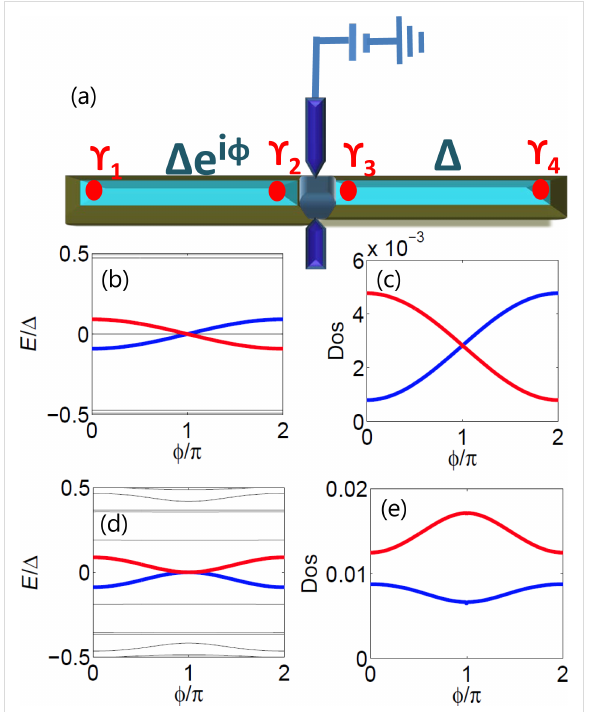
Figure 1: (a) Schematic setup of an experiment in which two STM leads or normal leads are connected to a Top-JJ that supports the MFs. (b) Energy spectrum of the Top-JJ with chemical potential μ = − 2 t , which lies in the topological region. The two MFs, which are localized at the junction, interfere with each other and display a 4 π oscillation. (c) DOS for electron part of the coupled MFs in the Top-JJ. Both even parity state and odd parity state show a parity-correlated 4 π oscillation. (d) Energy spectrum of the Top-JJ with chemical potential μ = − 2 t + 5.7 Δ , which lies in the trivial region, and the disorder strength w = 0.13 t . In this case, there does not exist any MF that is localized at the junction. However, the trivial Andreev bound states occasionally touch with each other in the presence of disorder. In such situation, the trivial Andreev bound states behave like the Andreev bound states formed by the two MFs in panel (b). (e) DOS of the trivial Andreev bound states for the electron part. It is totally different from the DOS of the nontrivial Andreev bound states in panel (c). The period of the trivial state is 2 π